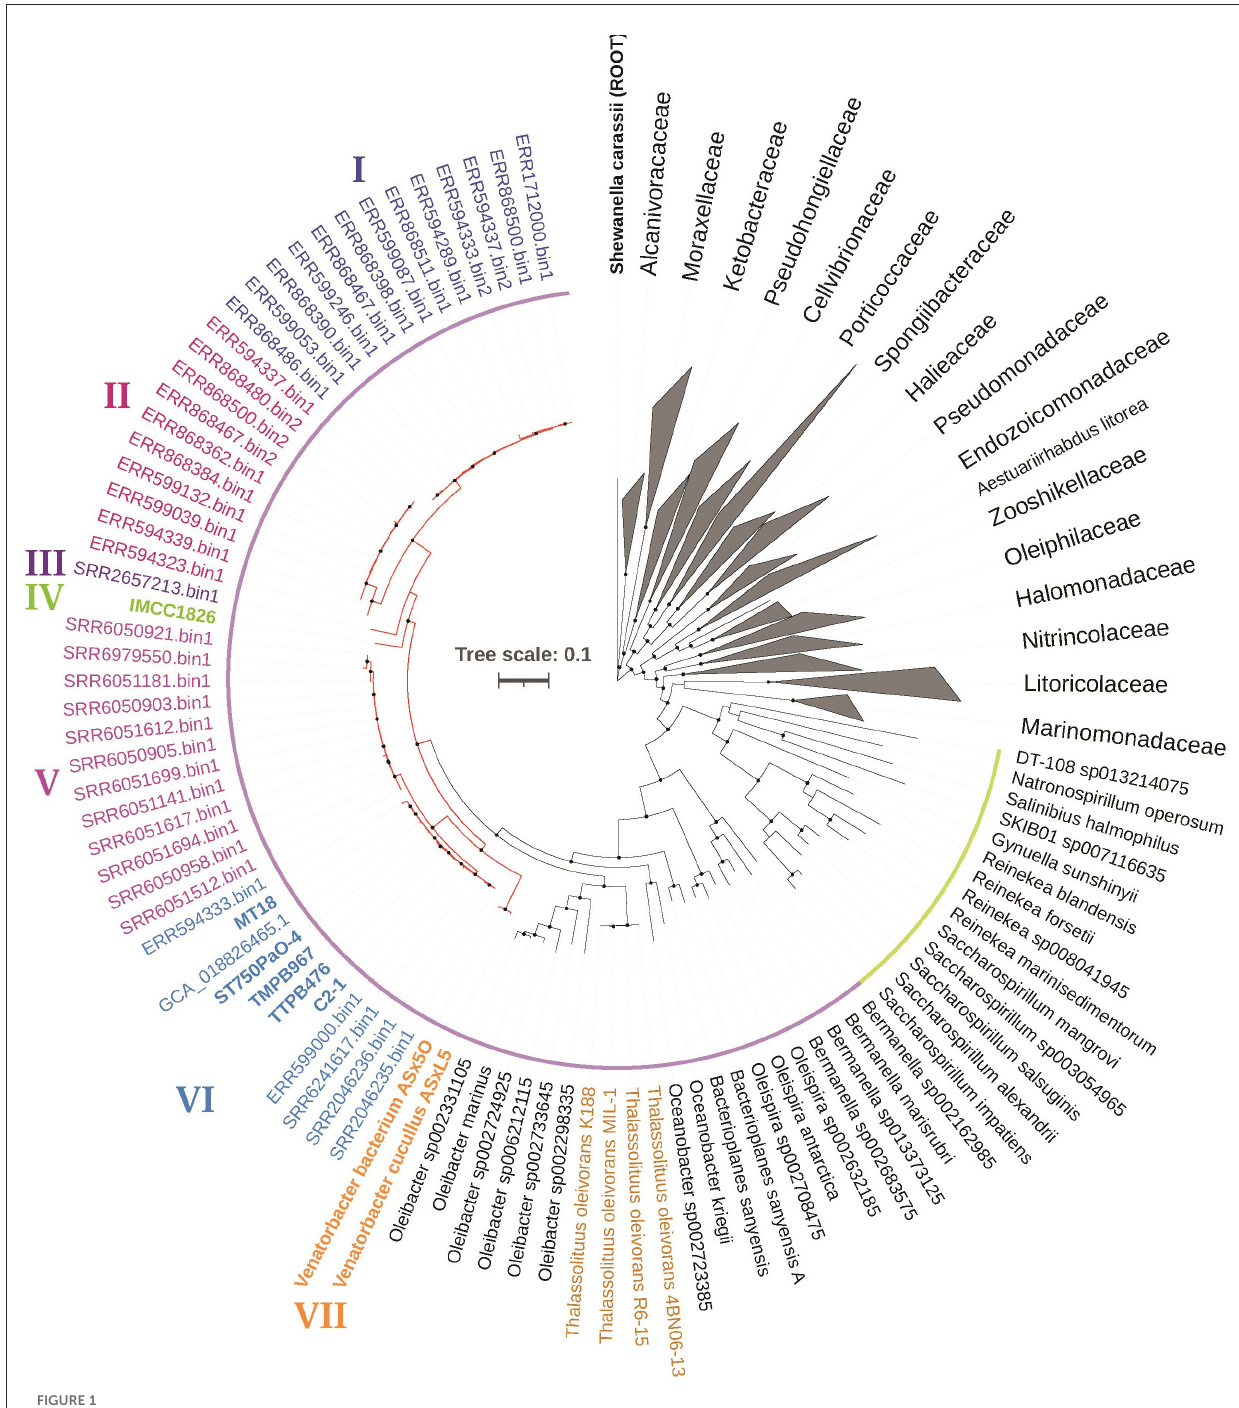
FIGURE1 Phylogeny of Venatorbacter species and their related species based on 120 concentrated proteins. The two branches of the family Saccharospirillaceae in GTDB taxonomy were highlighted in yellow and purple, respectively. The branches of Venatorbacter are highlighted in red. Clades I to VII of Venatorbacter are in different colors. The genus Thalassolituus is highlighted in brown. The black nodes point to the bootstrap values ≥ 80.